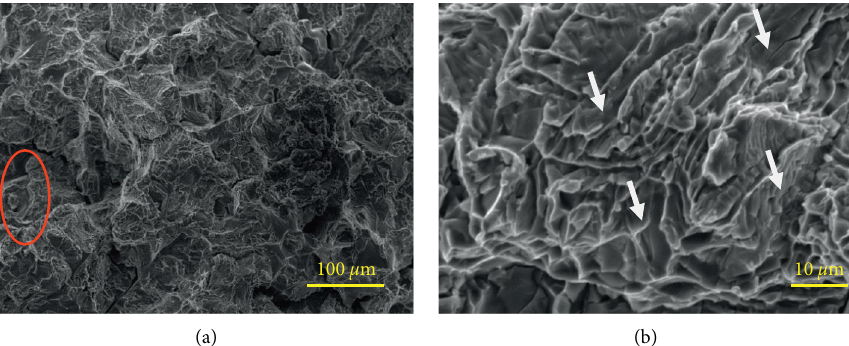
Figure 1: Cast LM-13 alloy (a) aluminum dendrites surrounded by Si particles (b) Si eutectic is present in plastic form with